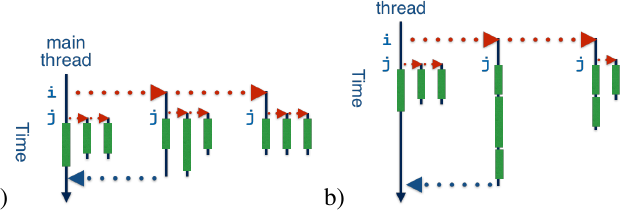
Fig. 2. Possible distributions of work for nested for loops shown in Figure 1. Sub-figure a) shows the optimal distribution when a total of 9 threads are used. Sub-figure b) shows one potential sub-optimal distribution where only a maximum of 6 threads are